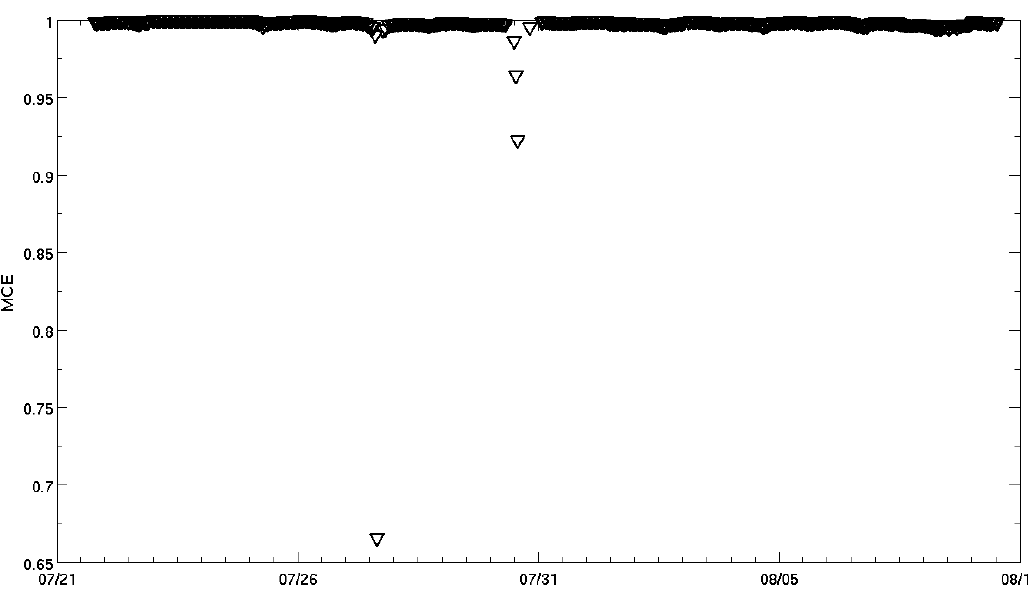
Figure 4. Time series of MCE at Pallas